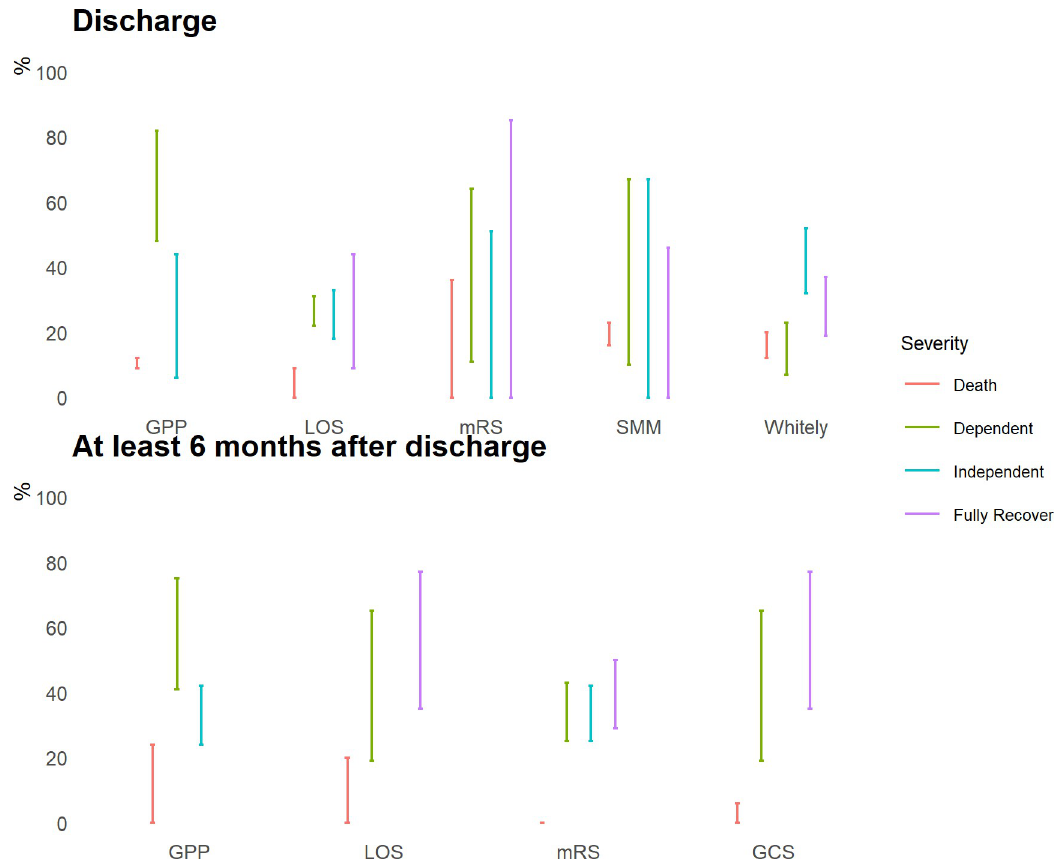
Fig 7. Range of Japanese encephalitis (JE) neurological deficits severity level by outcome measurement time and assessment tools. We define dependent as JE survivors who need assistance to perform daily activities and independent as JE patients who can live independently. JE patients with complete recovery show no symptoms of any neurological sequelae. Death measured at least 6 months after hospital discharge excludes death occurred during the acute stage of JE infection. Abbreviations: GPP (Good/Partial/ Poor), Liverpool Outcome Score (LOS), Modified Rankin Scale (mRS), SMM (Severe/Moderate/Minor), Glasgow Coma Scale